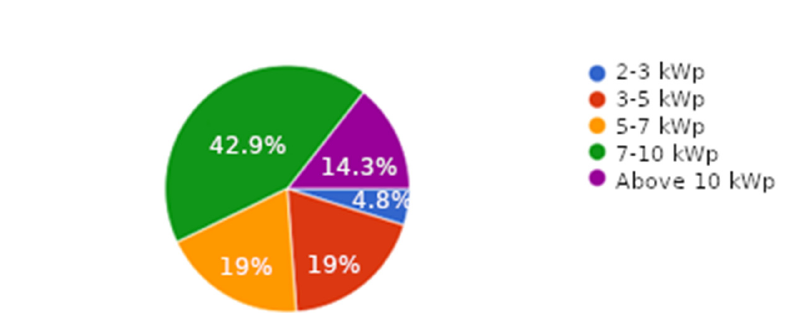
10 kWp (Figure 2).